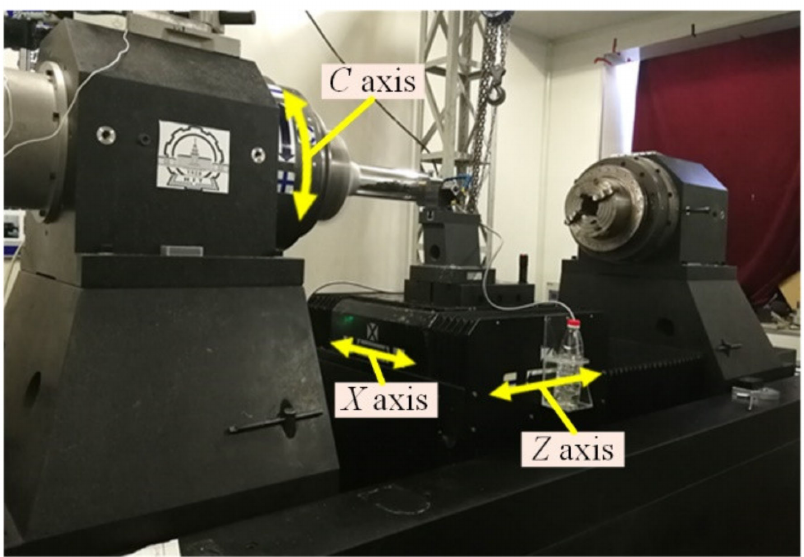
Figure 13. Cutting experiment of the mandrel roundness error compensation.